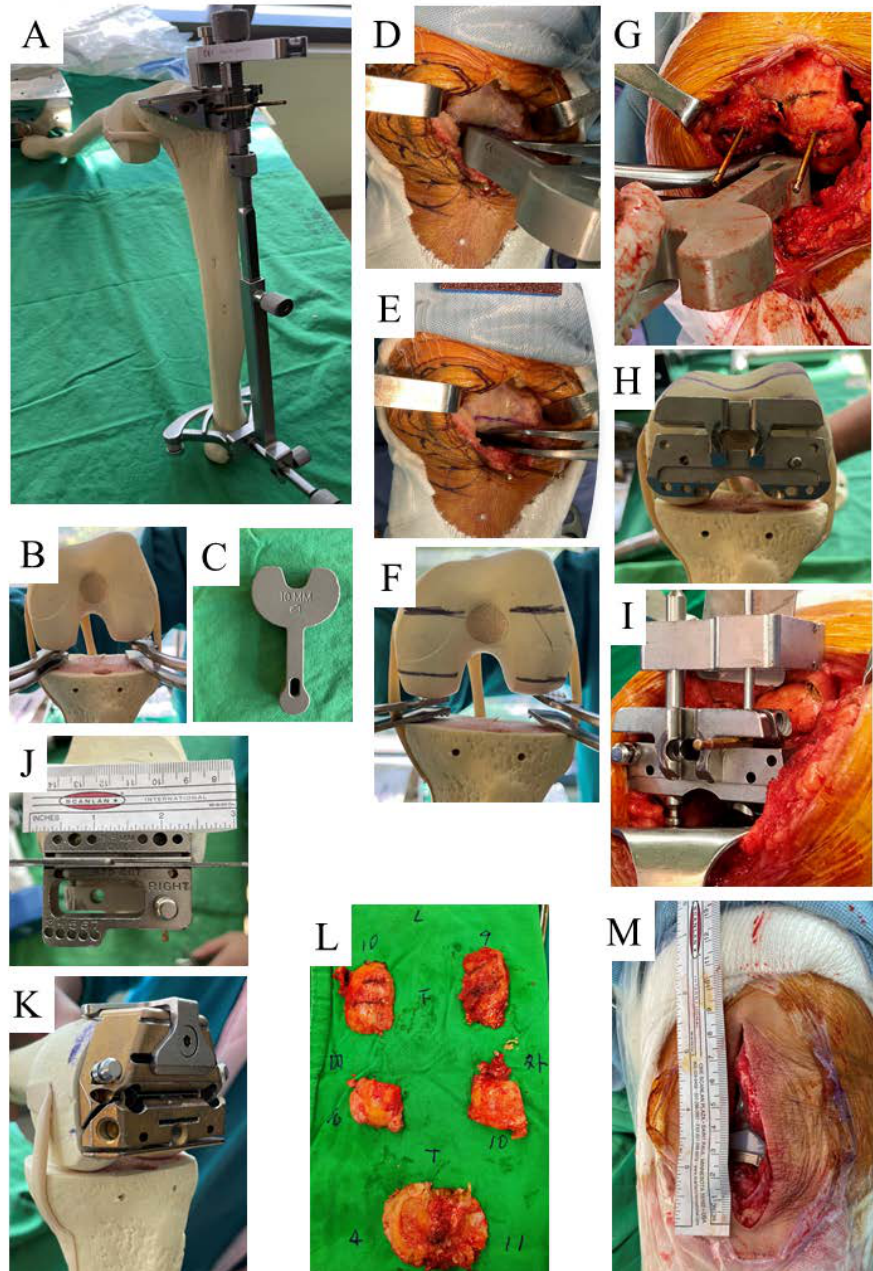
Figure 1. The procedure of inverse restricted KA (irKA)-TKA is illustrated. ( A ) Tibia cut was conducted first. ( B ) Laminar spreaders were used to provide tension. ( C ) A 10 mm block-spreader was used for assisting irKA. ( D , E ) The posterior cut was planned. ( F ) Femoral rotation was planned parallel to the resection line at the posterior femoral bone. ( G ) A 10 mm block-spreader was inserted and a parallel line against the epicondylar line was drawn. Two pins were anchored for chamfer. ( H ) The IM external-rotation guide-plate was positioned by aligning the line of femoral rotation. ( I ) Anterior cut was conducted. ( J ) Determine the cutting angle based on drawn line. ( K ) Distal cut preparation. ( L ) Resected bones were shown. ( M ) The size of wound.